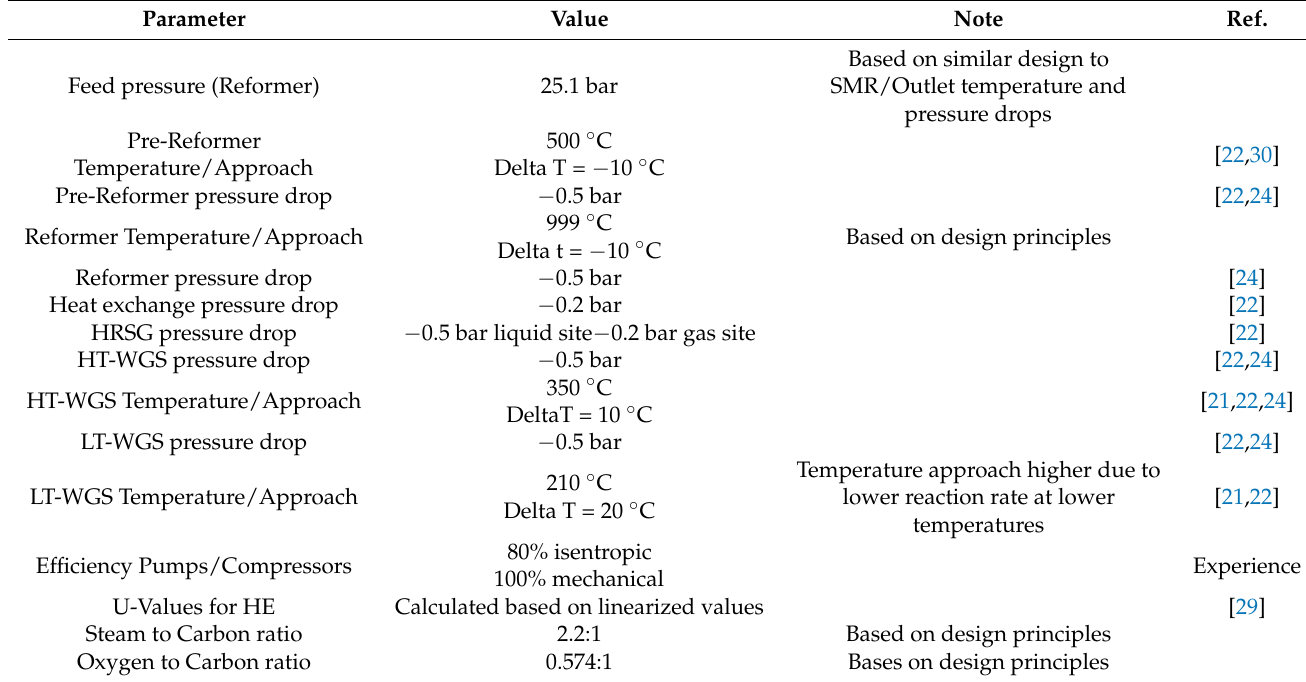
Table 4. Key modeling parameters for ATR